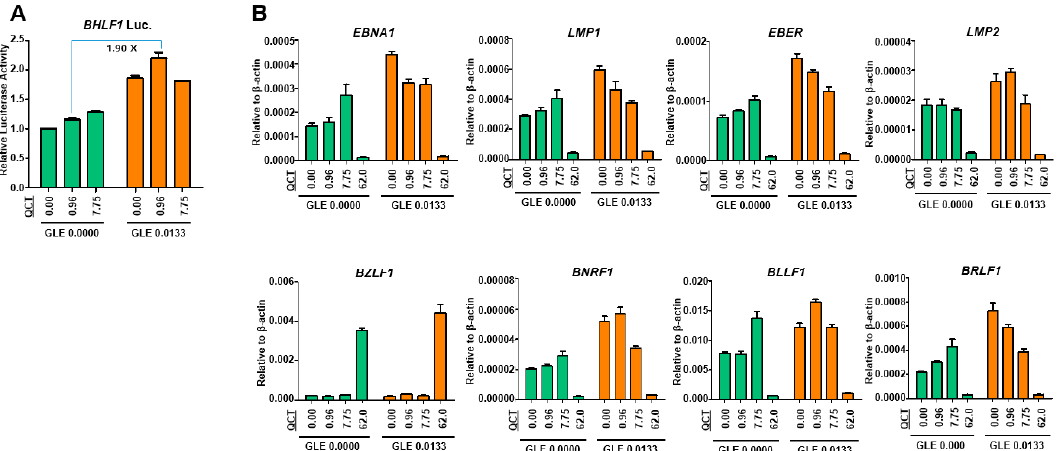
Figure 5. Cotreatment with GLE and QCT induced EBV lytic reactivation and gene expression. Luciferase assay was conducted to determine EBV lytic reactivation in SNU719-BHLF1 luciferase cells. Relative luciferase activity measured in the SNU719-BHLF1 luciferase cells. ( A ) SNU719-BHLF1 luciferase cells were treated with low-concentration GLE (0.0133 mg/mL) and various concentrations of QCT to evaluate their stimulatory effects on EBV lytic reactivation. SNU719 cells were treated with both various concentrations of QCT and 0.0133 mg/mL GLE. ( B ) The determination of the effects of various concentrations of QCT + GLE (0.0133 mg/mL) on the EBV gene expression. GLE and QCT: Ganoderma lucidum extracts and quercetin, respectively.